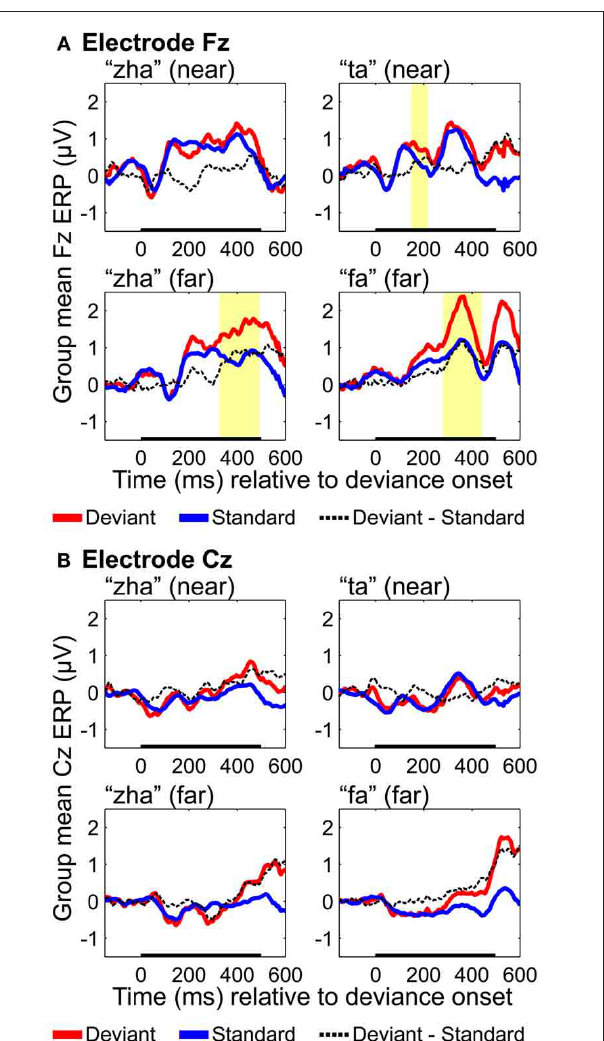
FIGURE 9 | Group mean ERPs and MMN analyses for (A) electrode Fz and (B) electrode Cz. Group mean ERPs are shown for “zha” in the near context, “ta” in the near context, “zha” in the far context, and “fa” in the far context. Times shown are relative to stimulus deviation onset. Highlighted time regions show statistically significant ( p < 0 . 05) differences of ERP evoked by the deviant from the ERP evoked by the standard, corrected for multiple comparisons over time. Statistical comparisons were performed for the times indicated by the heavy black line along the time axis. Reliable positive differences (deviant vs. standard) were obtained on electrode Fz for the two far syllable contrasts and for the near syllable contrast “ta.” No reliable differences were obtained on electrode